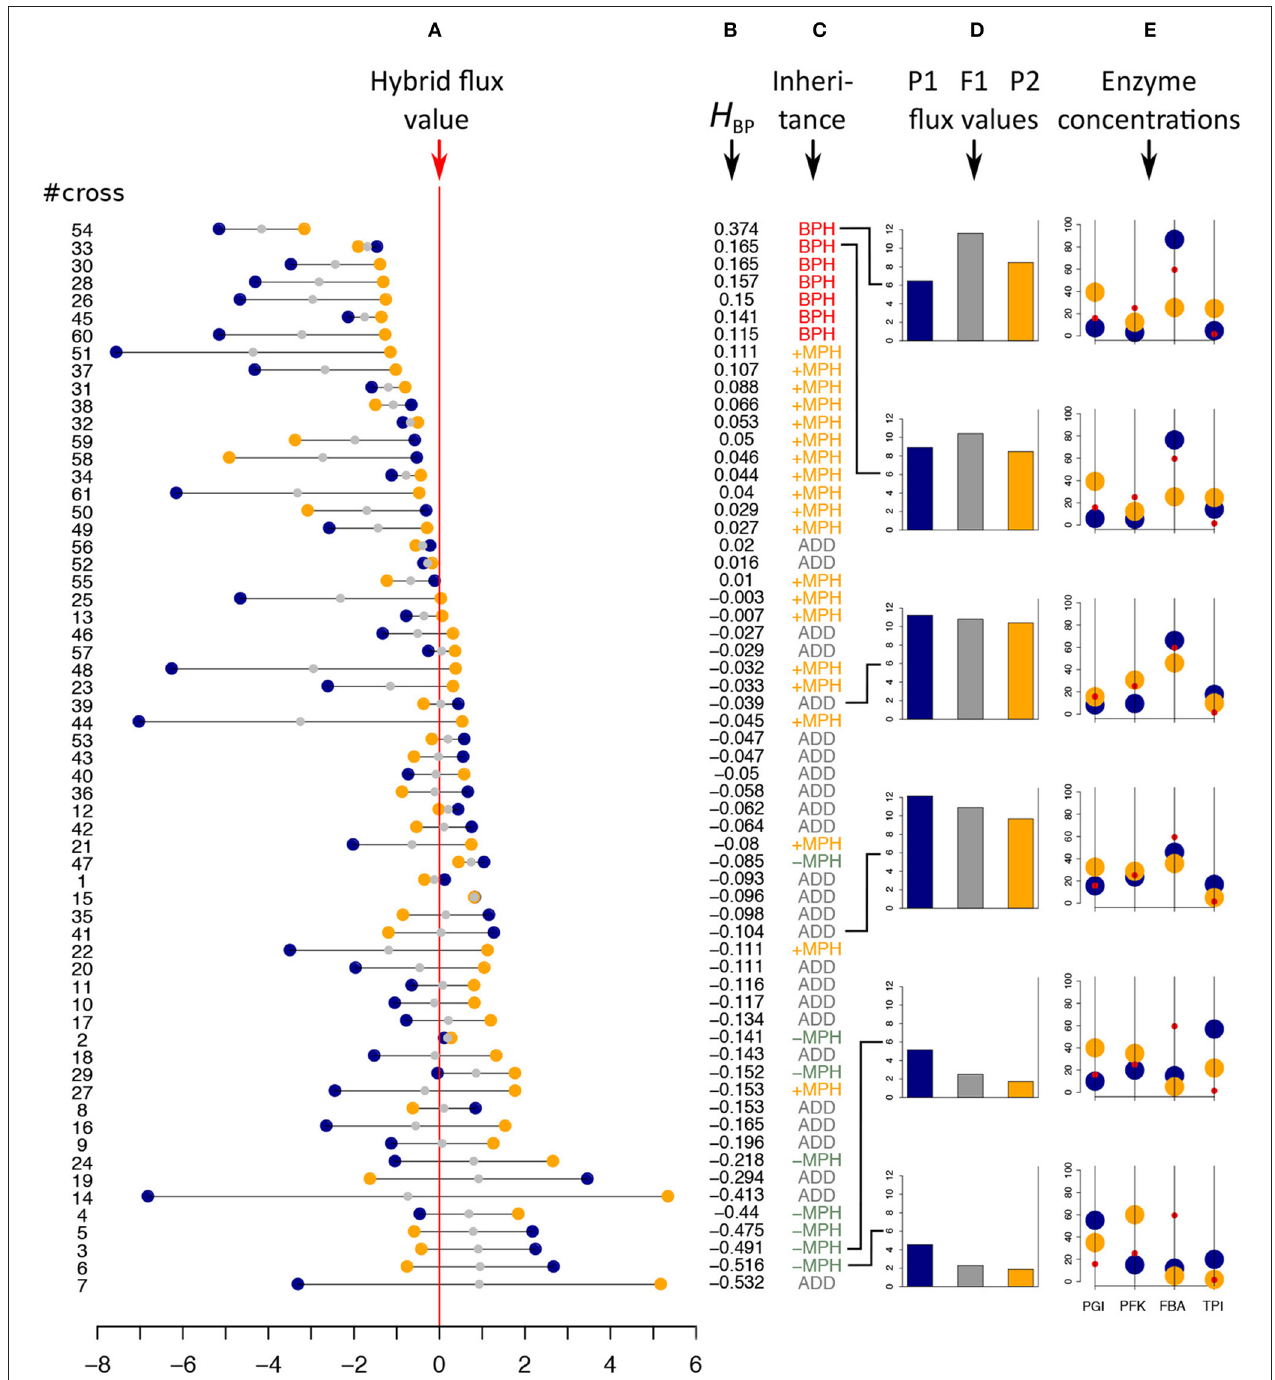
FIGURE 5 | In vitro heterosis. Hybrids were created by mixing 1:1 the content of parental tubes. # cross refers to the cross numbers of Table S1. (A) Parental flux values (blue and orange points) relative to the hybrid flux value used as a reference (vertical red line) for the 61 crosses (in µ M.s − 1 ). Gray points indicate the mid-parental values. Crosses were ranked by decreasing H BP values, the index of best parent heterosis. (B) H BP values. (C) Inheritance: BPH, Best-Parent Heterosis; +MPH, positive Mid-Parent Heterosis; ADD, additivity; –MPH, negative Mid-Parent Heterosis. (D,E) Parental (blue and orange bars) and hybrid (gray bars) flux values, alongside the corresponding parental enzyme concentrations for six crosses, identified by broken lines, displaying different types of inheritance. From top to bottom: the two crosses with the highest significant BPH values, the two crosses that are the closest to additivity and the two crosses with the smallest significant –MPH values. Red points correspond to the optimal enzyme